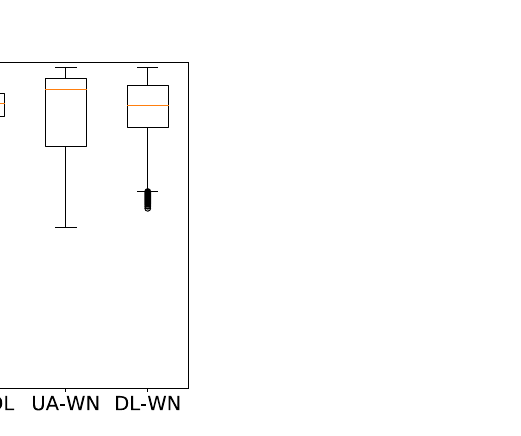
Figure 11. Distribution of the network distance for the pairs of